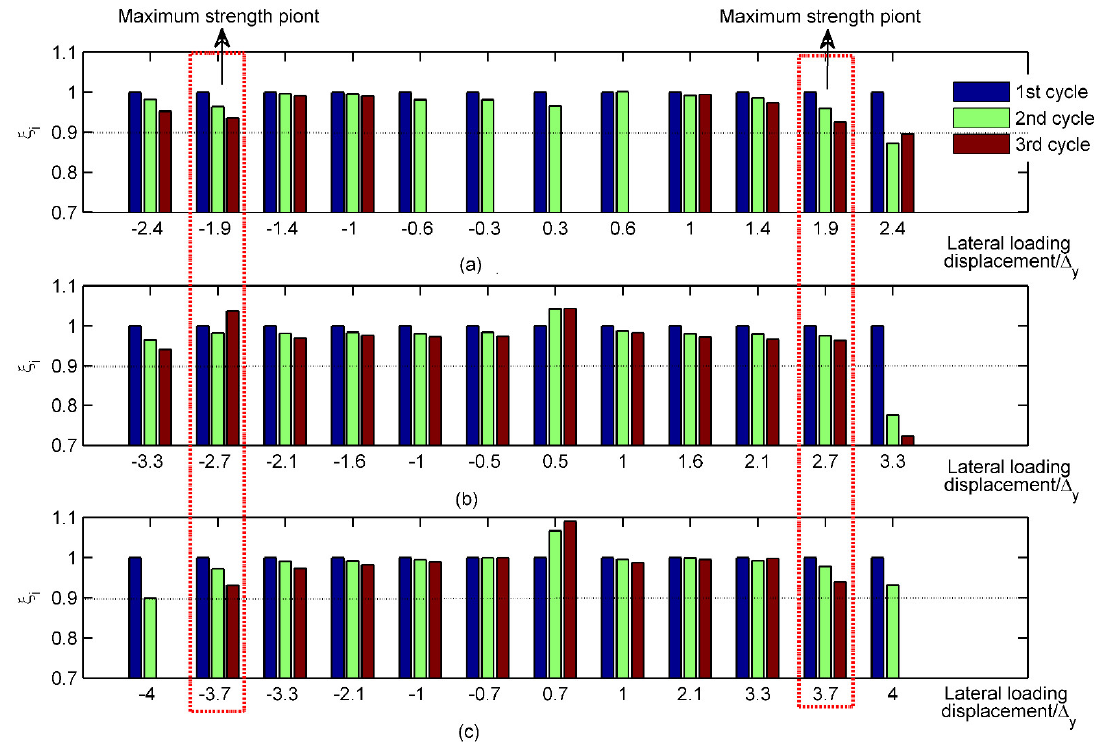
Figure 13. Strength degradation ratio of different specimens: ( a ) specimen SPSW; ( b ) specimen SPCSW; ( c ) specimen DPCSW.